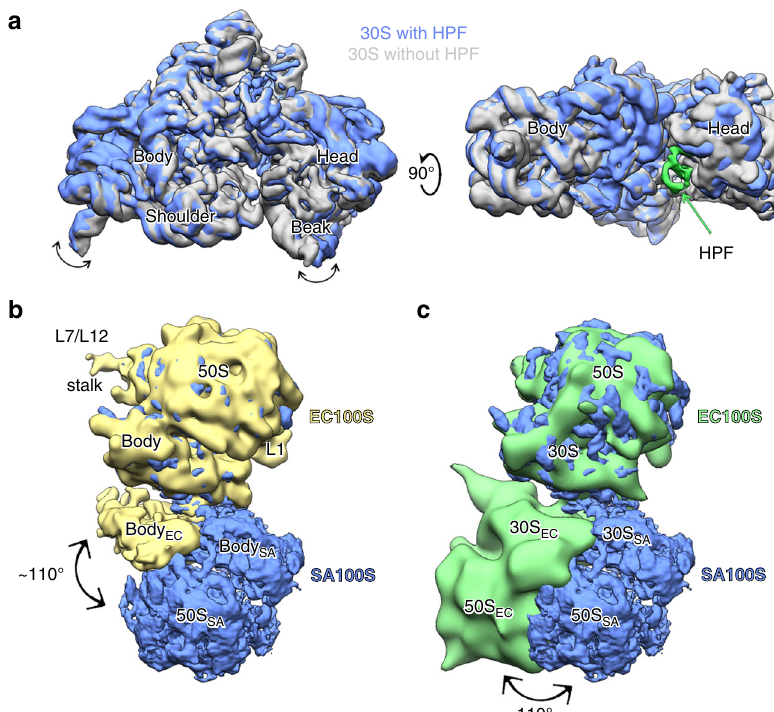
Fig. 4 Structural differences of C-HPF SA bound/unbound 30S subunits and S. aureus vs. E. coli 100S structures. a Superposition of two small ribosomal subunits; bound and unbound to HPF from two views demonstrates conformation change upon C-HPF SA binding. The bound 30S is in blue and the unbound is in gray . The density of C-HPF SA is shown on the top panel . Arrows demonstrate the movement directions of the 30S head and body upon binding. b , c Superposition of SA100S (in blue ) on b . Single-particle cryo-EM map of part of EC100S (in yellow , EMDB code EMD-1750) and c cryo-EM tomogram of EC100S (in green , EMDB code